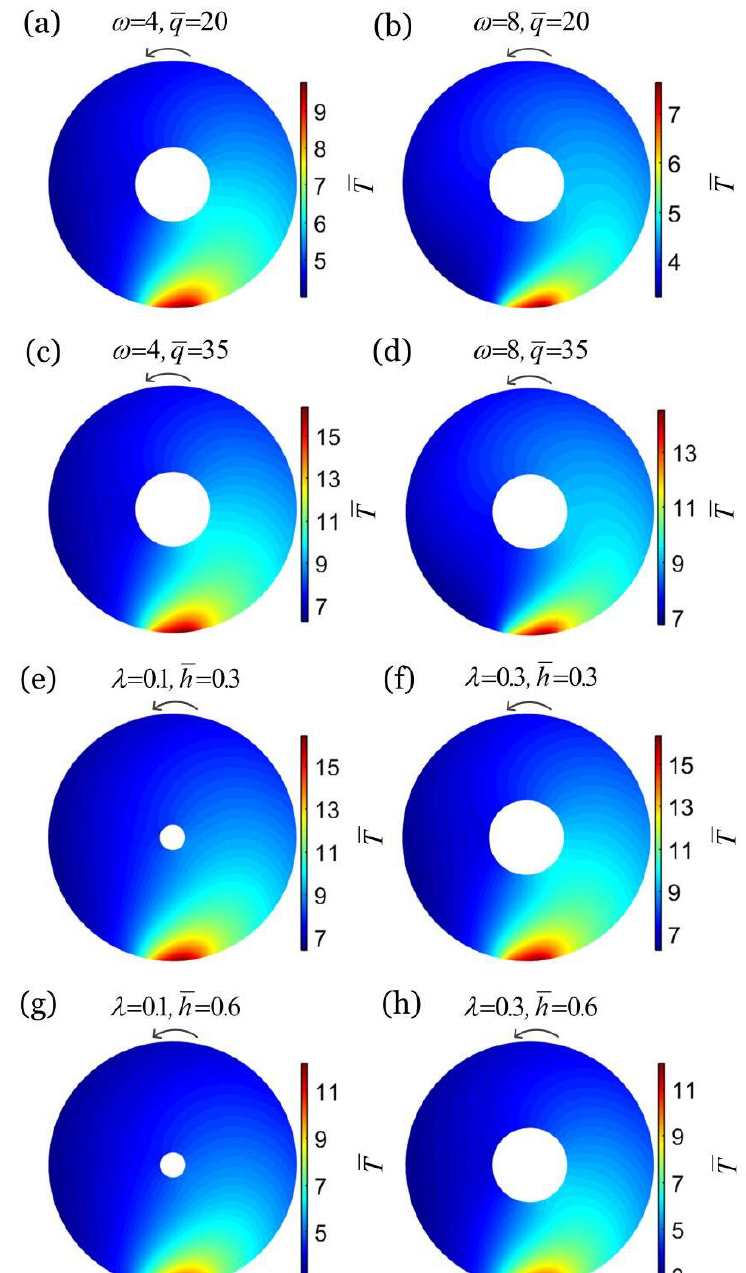
Figure 2. Temperature fields on the cross section of a thick-walled cylindrical rod in steady-state rolling for different combinations of rolling angular velocity ω and heat flux q : ( a ) ω = 4, q = 20, ( b ) ω = 8, q = 20, ( c ) ω = 4, q = 35, ( d ) ω = 8, q = 35, and different combinations of radius ratio λ and heat transfer coefficient h : ( e ) λ = 0.1, h = 0.3, ( f ) λ = 0.3, h = 0.3, ( g ) λ = 0.1, h = 0.6, ( h ) λ = 0.3, h = 0.6. We set h = 0.3, λ = 0.3, and θ 0 = 0.2 in a–d, and ω = 4, q = 35 and θ 0 = 0.2 in e–h. In this case, the rolling velocity of the rod is one of the input parameters. When the thick-walled cylindrical rod rolls steadily, the non-uniformity of the temperature field on the cross section decreases with the increase in rolling angular velocity ω and heat transfer coefficient h , and increases with the increase in heat flux q and radius ratio λ .